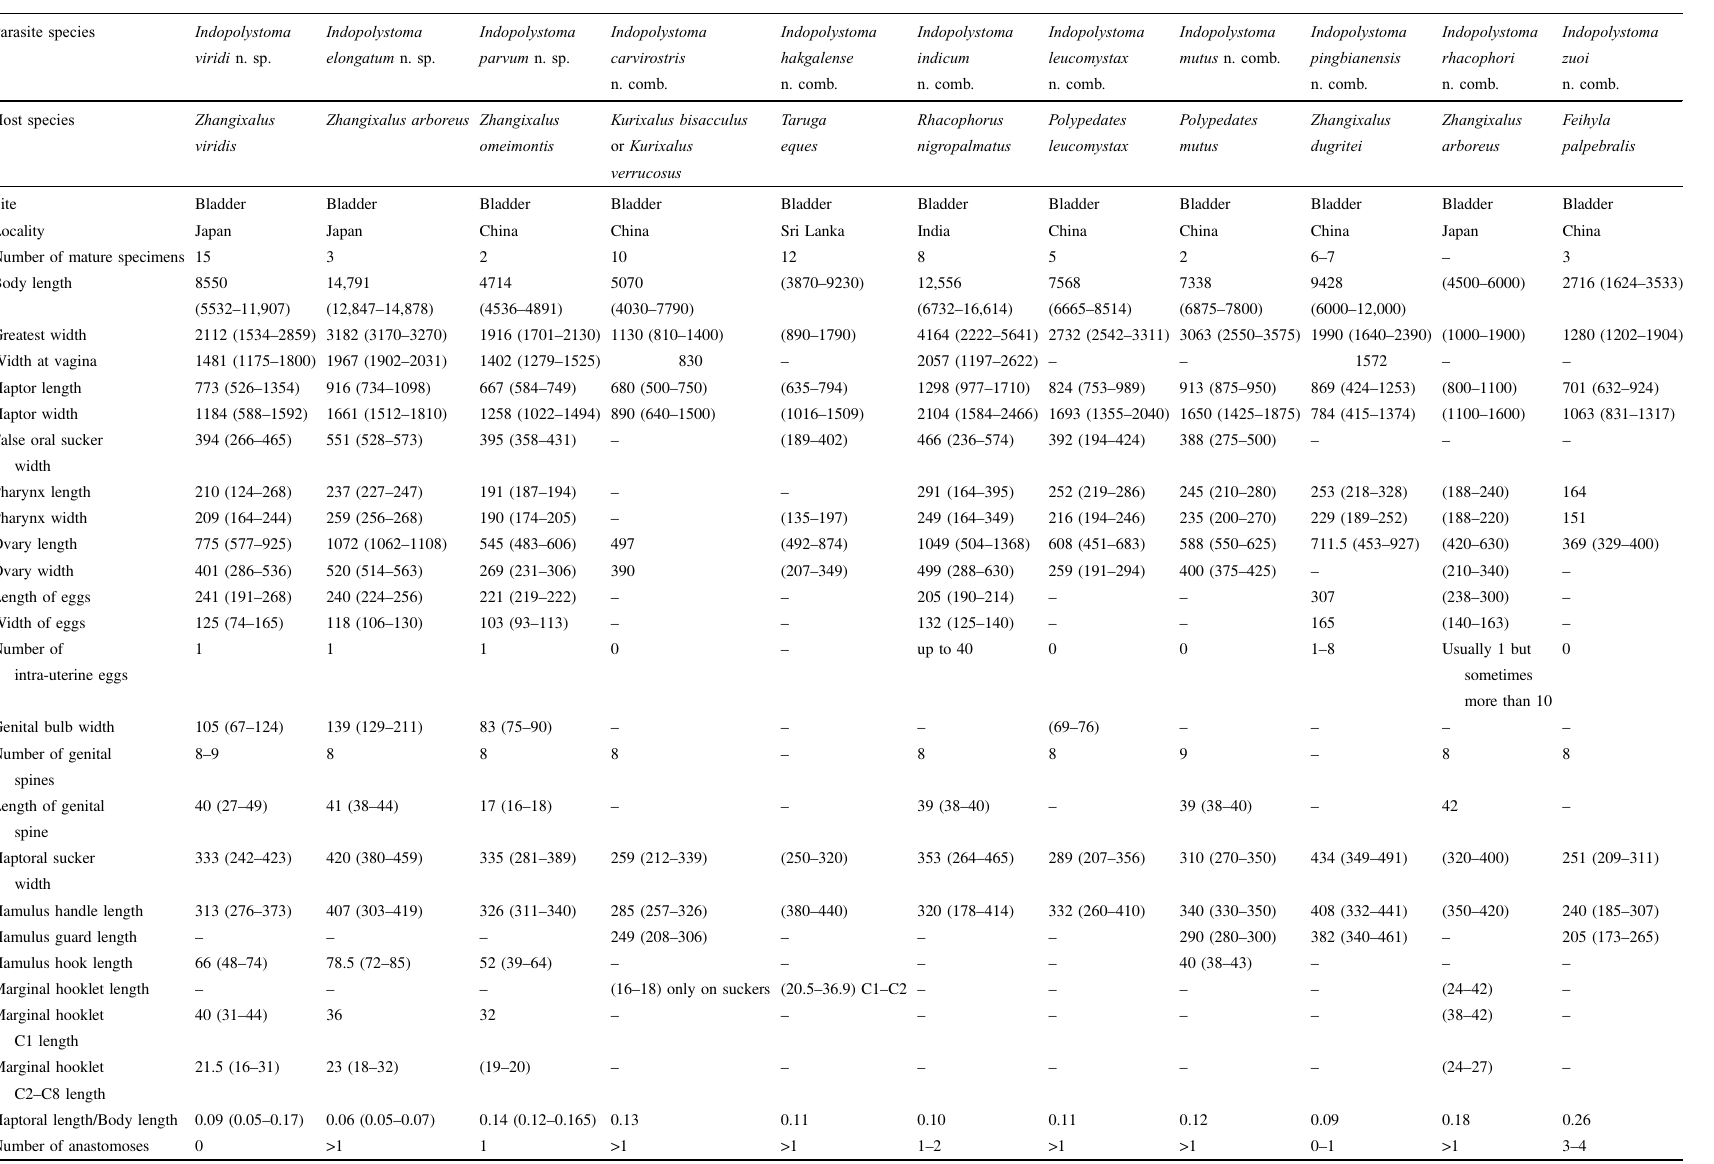
Table 4. Body measurements of Indopolystoma